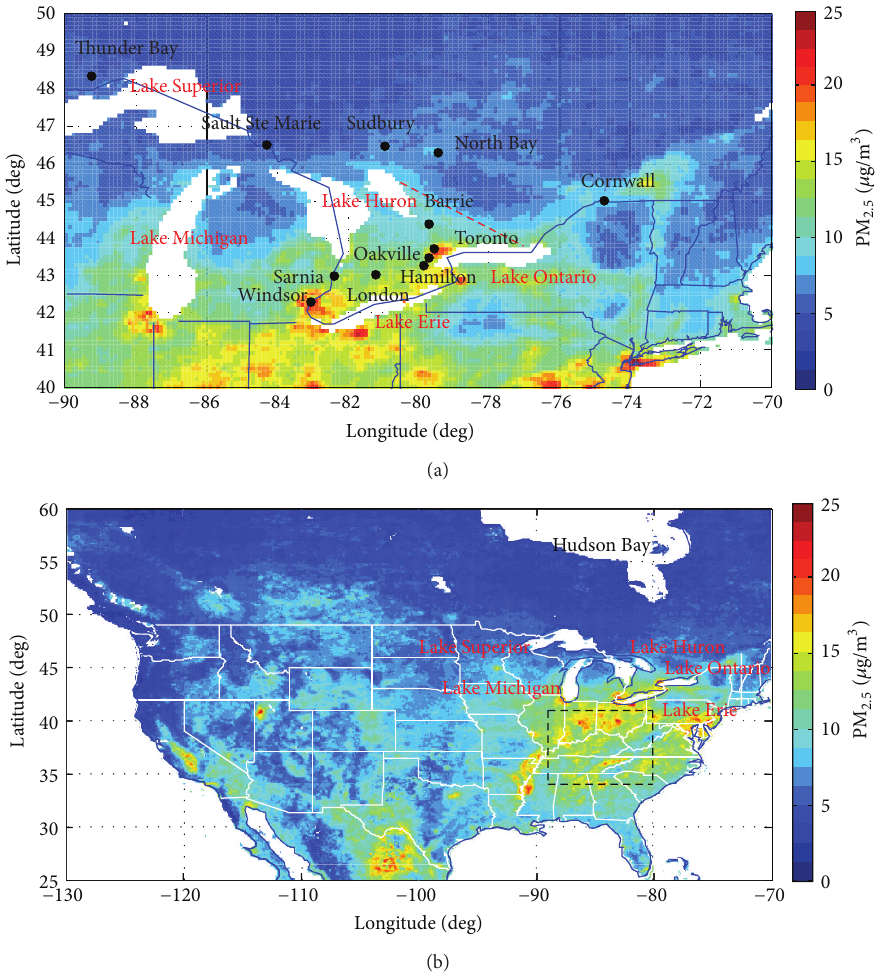
Figure 1: (a) Study area including 12 cities in Ontario, Canada, overlaid with the annual mean PM 2.5 concentrations ( 𝜇 g/m 3 ) derived from satellite measurements between 2001 and 2006 at 0.1 ∘ × 0.1 ∘ resolution [22]. The Greater Golden Horseshoe and Southwestern Ontario regions are within the area between the dashed line and the boundary of the two countries. (b) PM 2.5 distribution over North America from the same data source as in (a). The boxed area approximately indicates the Ohio River Valley region. The blue lines in (a) and white lines in (b) delineate the boundary between Canada and the United States of America (USA) and the state boundaries of